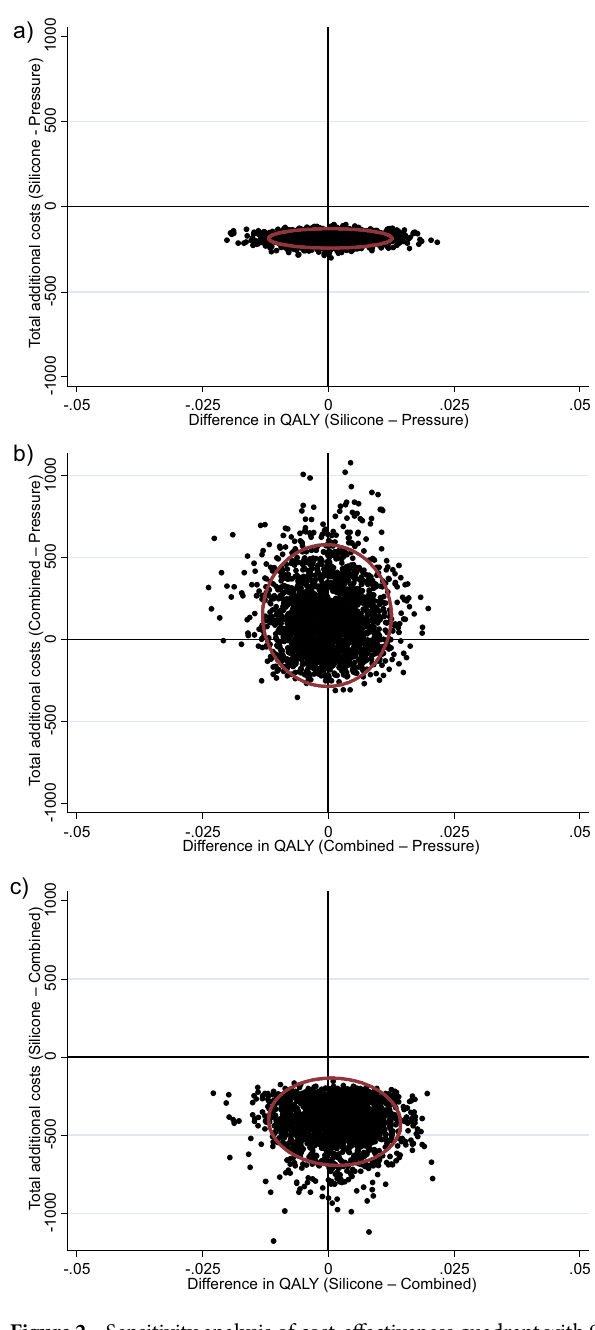
Figure 2. Sensitivity analysis of cost-effectiveness quadrant with 95% confidence ellipse (from bootstrap resampling) for cost (in Australian dollars) per additional Quality Adjusted Life Year (QALY) gained analysis for: ( a ) Pressure garment therapy versus Silicone (less cost); ( b ) Combined versus Pressure garment therapy and ( c ) Combined versus Silicone (less